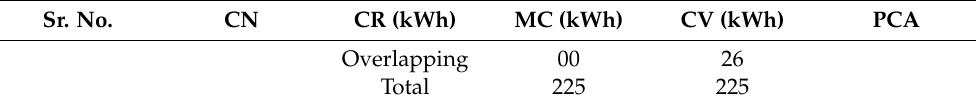
Table 12. Cont . Sr.